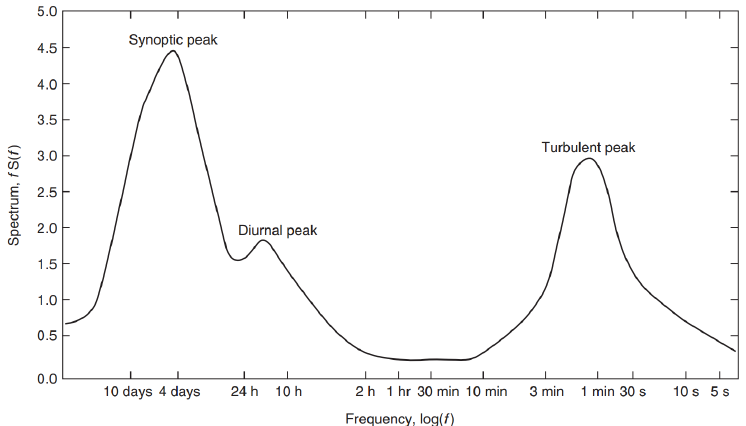
Figure 6. Turbulence, diurnal, and synoptic temporal variation peaks captured at Farm Brookhaven National Laboratory, U.S. [85], modified by [86], reproduced with permission from [85,86]. In contrast to turbulences that are not predictable, seasonal and diurnal wind changes are predictable. In comparison with seasonal variations, annual fluctuations are less predictable, but their changes are small. Synoptic variations are predictable as well, but not more than a few days ahead. Additionally, each of these variation types has a different effect on the power system, which is beyond the scope of this article but is investigated in detail in